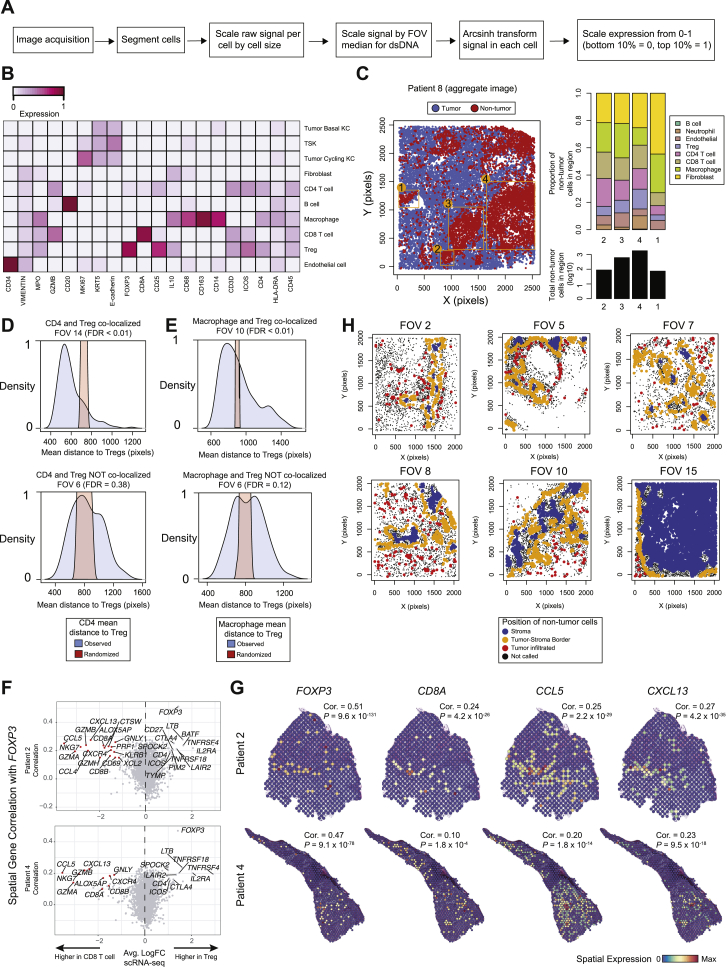
Multiplexed Ion Beam Imaging Acquisition and Analysis, Related to Figure 5(A) Workflow for image acquisition and standard processing to achieve marker quantification for single cells. (B) Heatmap representing scRNA-seq expression for genes exhibiting similar expression patterns in MIBI and scRNA-seq. (C) Plot of cell positions and tumor or normal status in large, tiled image from Patient 8 (2mm x 2mm). Regions outlined by squares are analyzed for composition of non-tumor cells (similar to Figure 5C). (D) Distribution of mean distance to Tregs for each CD4 T cell in blue. In red, CD4 cell identities were permuted among all non-tumor, non-CD4, non-Treg cells and the mean distance to Treg was re-calculated. (E) Similar to (D), analyzing macrophage to Treg distances. (F) Comparison of CD8 versus Treg differential expression and correlation with FOXP3 across ST spots for patients 2 and 4. (G) Spatial feature plots of Treg marker FOXP3 and CD8 effector/chemokine genes demonstrating co-localization. (H) Similar to Figure 5K. Cells were labeled as stromal (tumor-excluded), leading edge (tumor-stroma border), and infiltrated in tumor parenchyma.